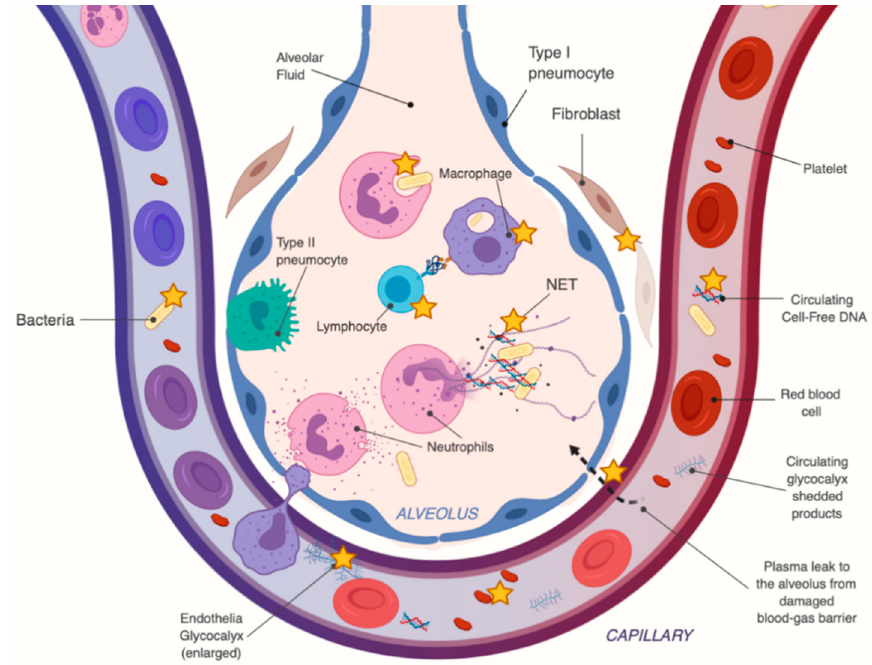
Figure 4. Pleiotropic effects of high-dose intravenous vitamin C (HDIVC) in sepsis-induced acute respiratory distress syndrome (ARDS). The orange star [ ✯ ] points to possible therapeutic targets of HDIVC. The figure illustrates a human alveolus with the capillary membrane, and the blood-gas barrier during sepsis.